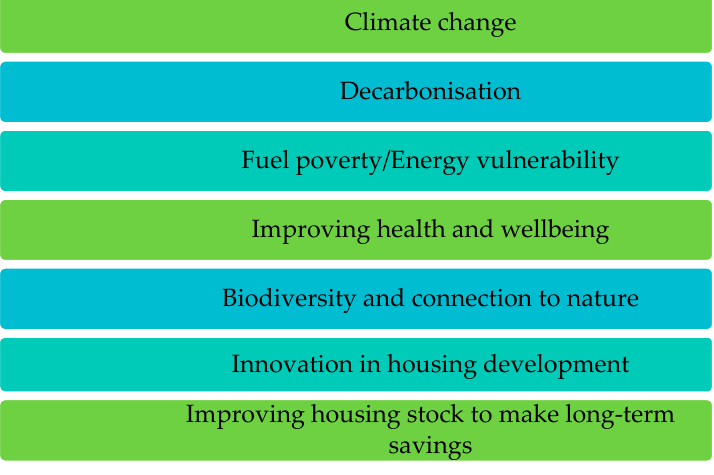
Figure 1. Developer motivations.